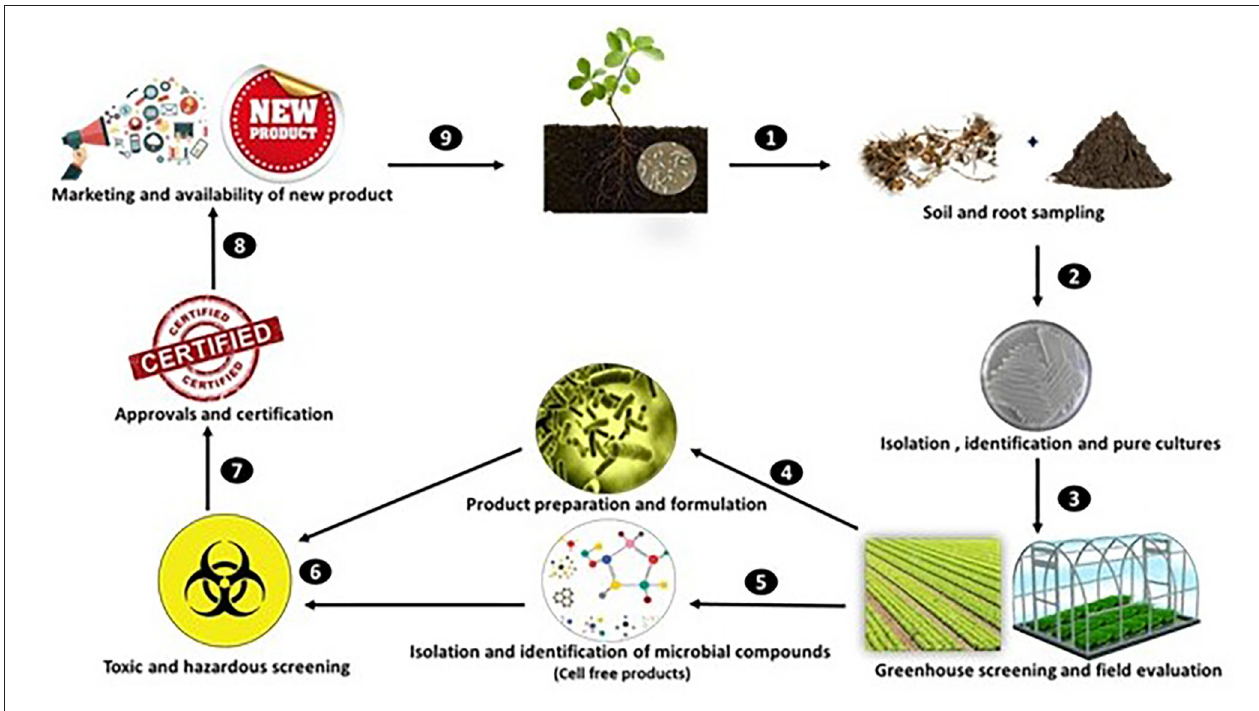
FIGURE 3 | Roadmap to the commercialization of biobased